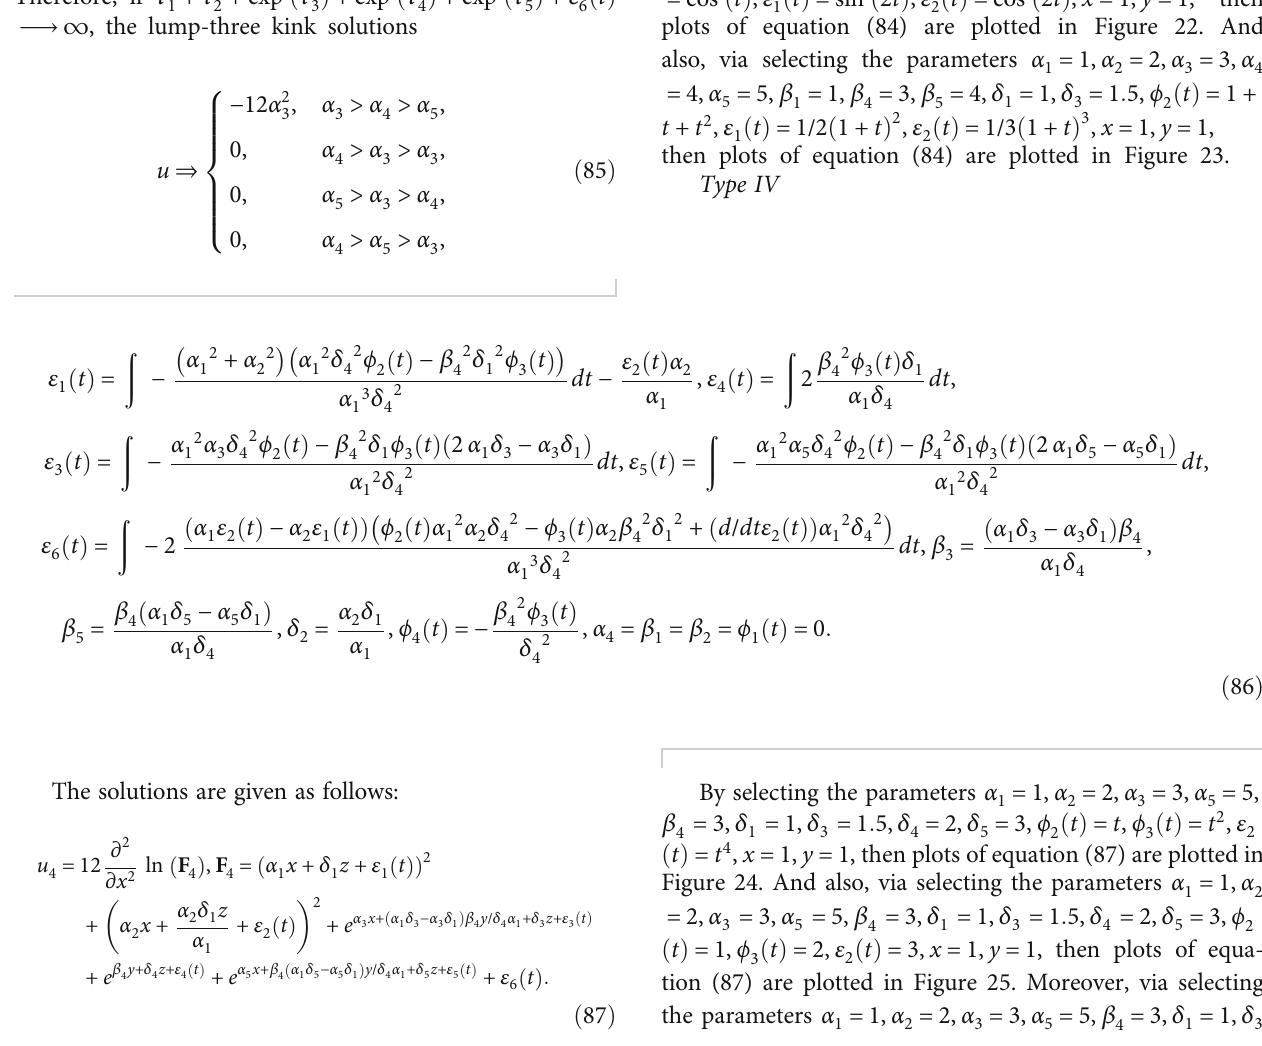
Figure 24. And also, via selecting the parameters α 1 = 1, α 2